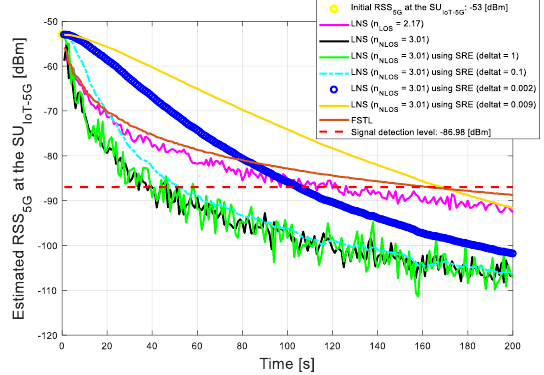
Figure 4 . Estimated RSS 5G at the SU IoT-5G vs. Time